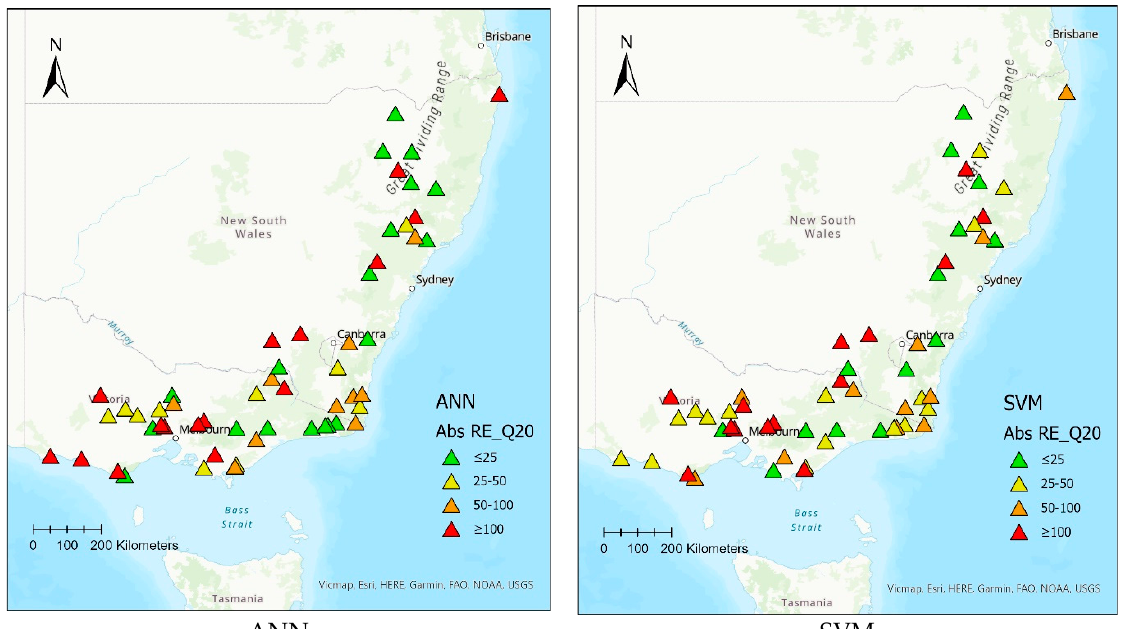
Figure 11. Spatial distribution of Abs RE values for ANN- Q 20 and SVM- Q 20 for 55 selected test catchments.